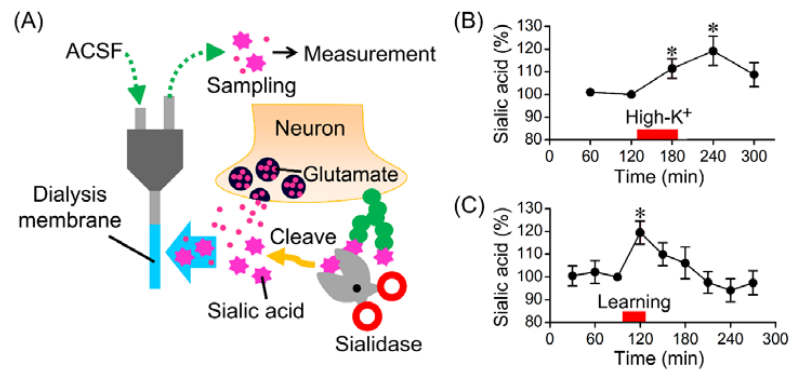
Figure 2. Sialic acid desorption during memory formation. ( A ) In vivo monitoring of sialic acid desorption using a microdialysis method. ( B , C ) Increase in the amount of sialic acid in the extracellular fluid of the rat hippocampus by depolarizing stimulation ( B ) or during context learning with fear conditioning ( C ) (* p < 0.05, vs. basal level).